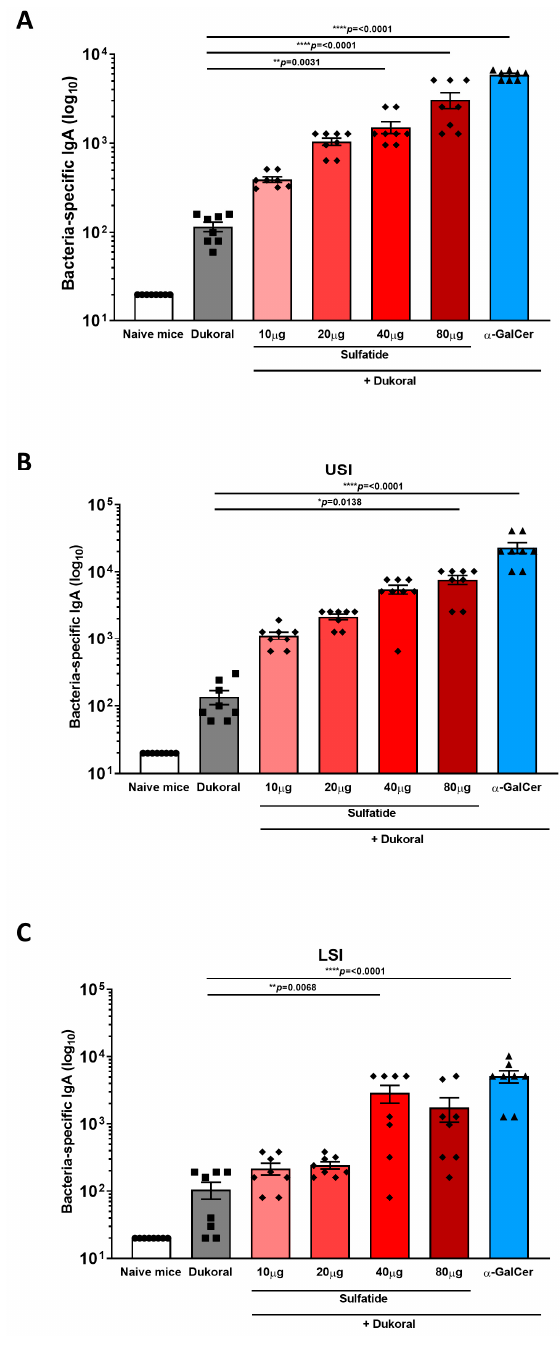
Figure 2. Sulfatide enhances intestinal Vibrio cholerae -specific IgA responses following oral co- administration with Dukoral ® . Female C57BL/6 mice were immunised orally with Dukoral ® co- administered with 10, 20, 40 or 80 µ g sulfatide, or 10 µ g α -GalCer in comparison with mice immunised with Dukoral ® alone or with PBS (naïve mice). On day 42 and 43, faecal pellets and intestinal tissues were collected, respectively. Endpoint titres of bacterium-specific IgA in faecal pellets ( A ), upper small intestine (USI) ( B ) and lower small intestine (LSI) ( C ) were determined by ELISA. Results presented are mean titres ± SEM. Significant differences between the group of mice vaccinated with Dukoral ® alone and Dukoral ® co-administered with an oral adjuvant are shown. Symbols show the groups of mice. Circles: naïve mice. Squares: mice immunised with Dukoral ® alone. Rhombus: mice immunised with Dukoral ® and sulfatide. Triangles: mice immunised with Dukoral ® and α -GalCer. Each symbol represents one animal in the